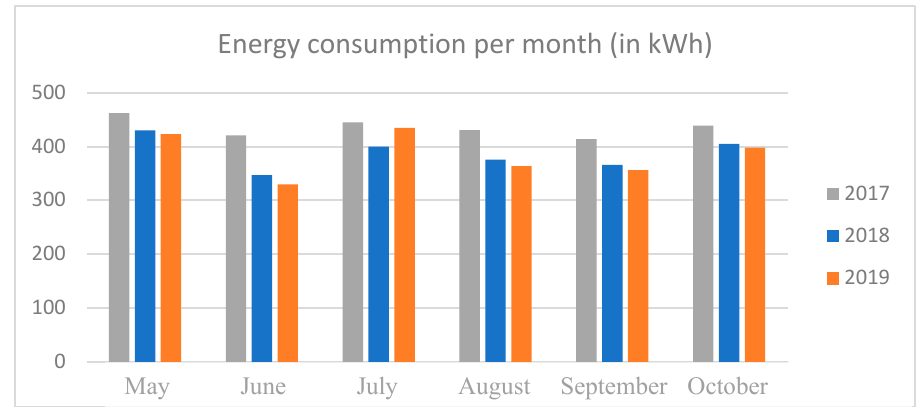
Figure 10. Energy consumption during the research period, compared with previous years in kWh.